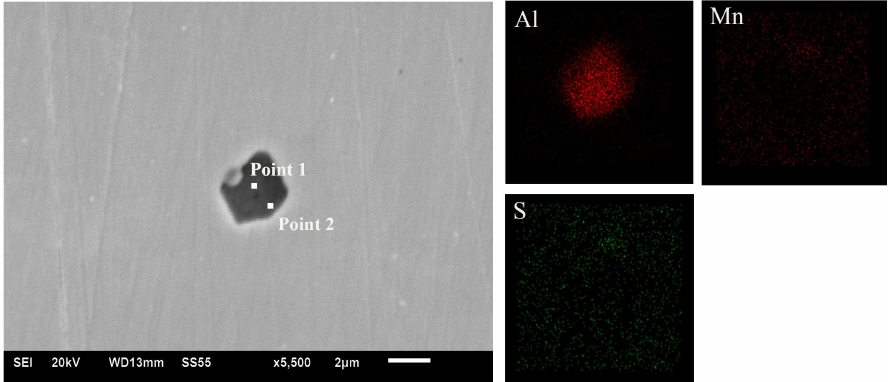
Table 1. Composition of samples (mass percentage/%).